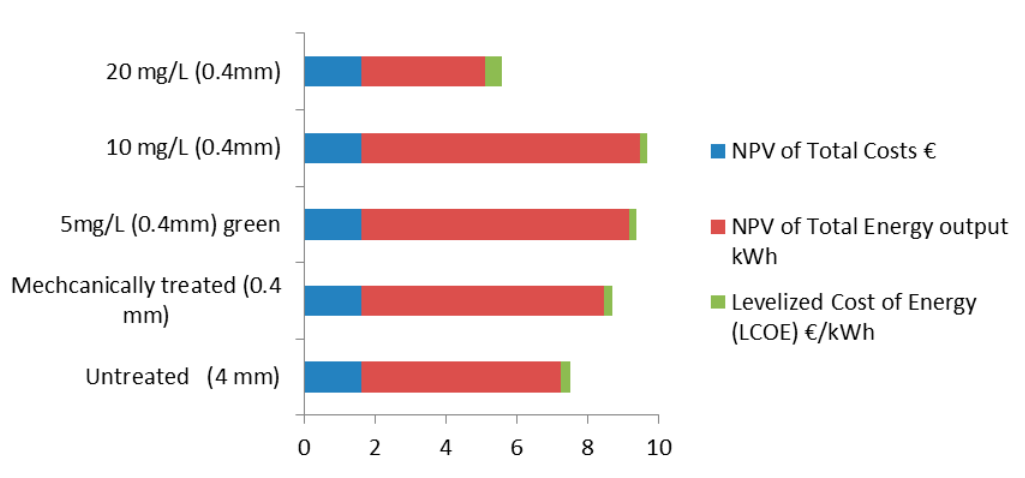
Figure 15. The net present value (NPV) € and levelized cost of energy (LCOE) € / kWh of the treated and untreated barley.